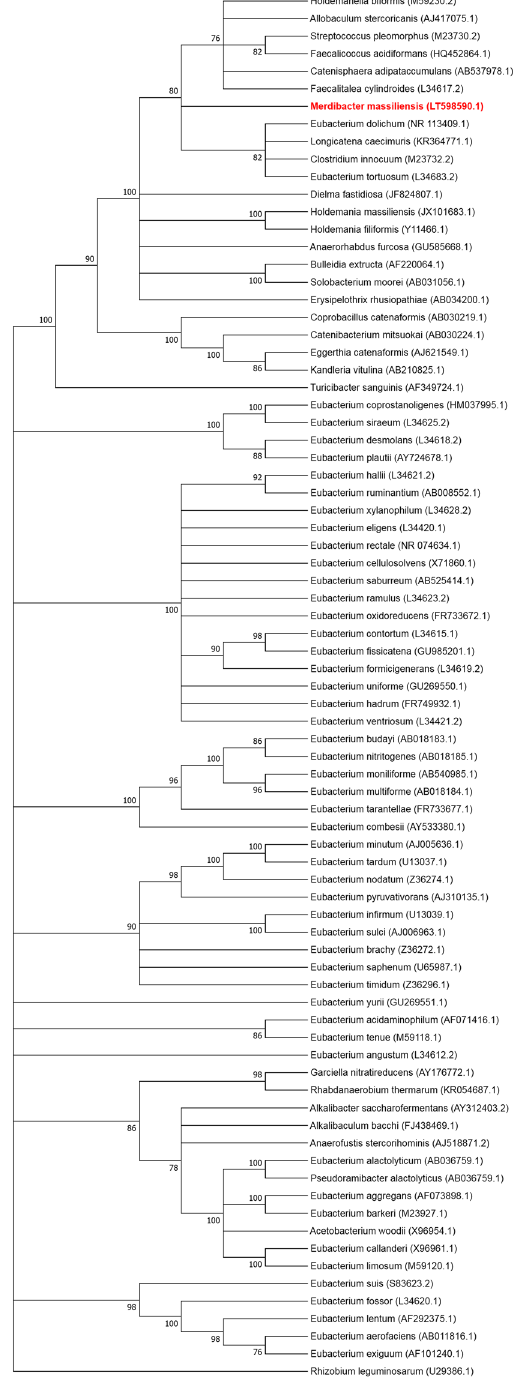
Figure 1. 16S rRNA-based phylogenetic tree highlighting the position of Merdibacter massiliensis gen. nov. sp., nov., strain Marseille-P3254 (red) relative to other closely related bacterial taxa within the family Erysipelotrichaceae as well as members of the family Eubacteriaceae . Genbank accession numbers are presented in parentheses. Sequences were aligned using Muscle v3.8.31 with default parameters and phylogenetic relationship inferred using the Maximum Likelihood method, with 1,000 bootstrap replicates, within the MEGA software version 7.0. Only values above 70% were indicated. Rhizobium leguminosarum was used as